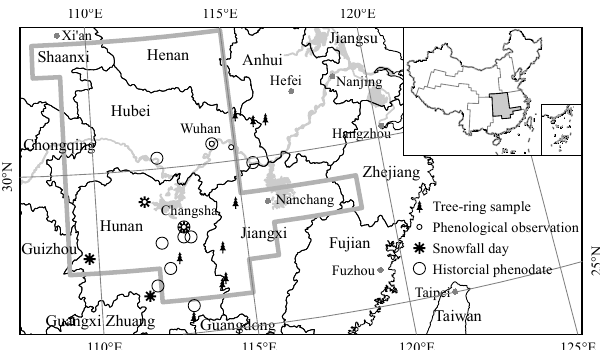
Figure 1. The study area and locations of proxy data used for an- nual temperature reconstruction in South Central China. Top right: subregions divided by the climate regionalization and the coher- ences of temperature change (cited from Wang et al., 1998). The gray area indicates South Central China.